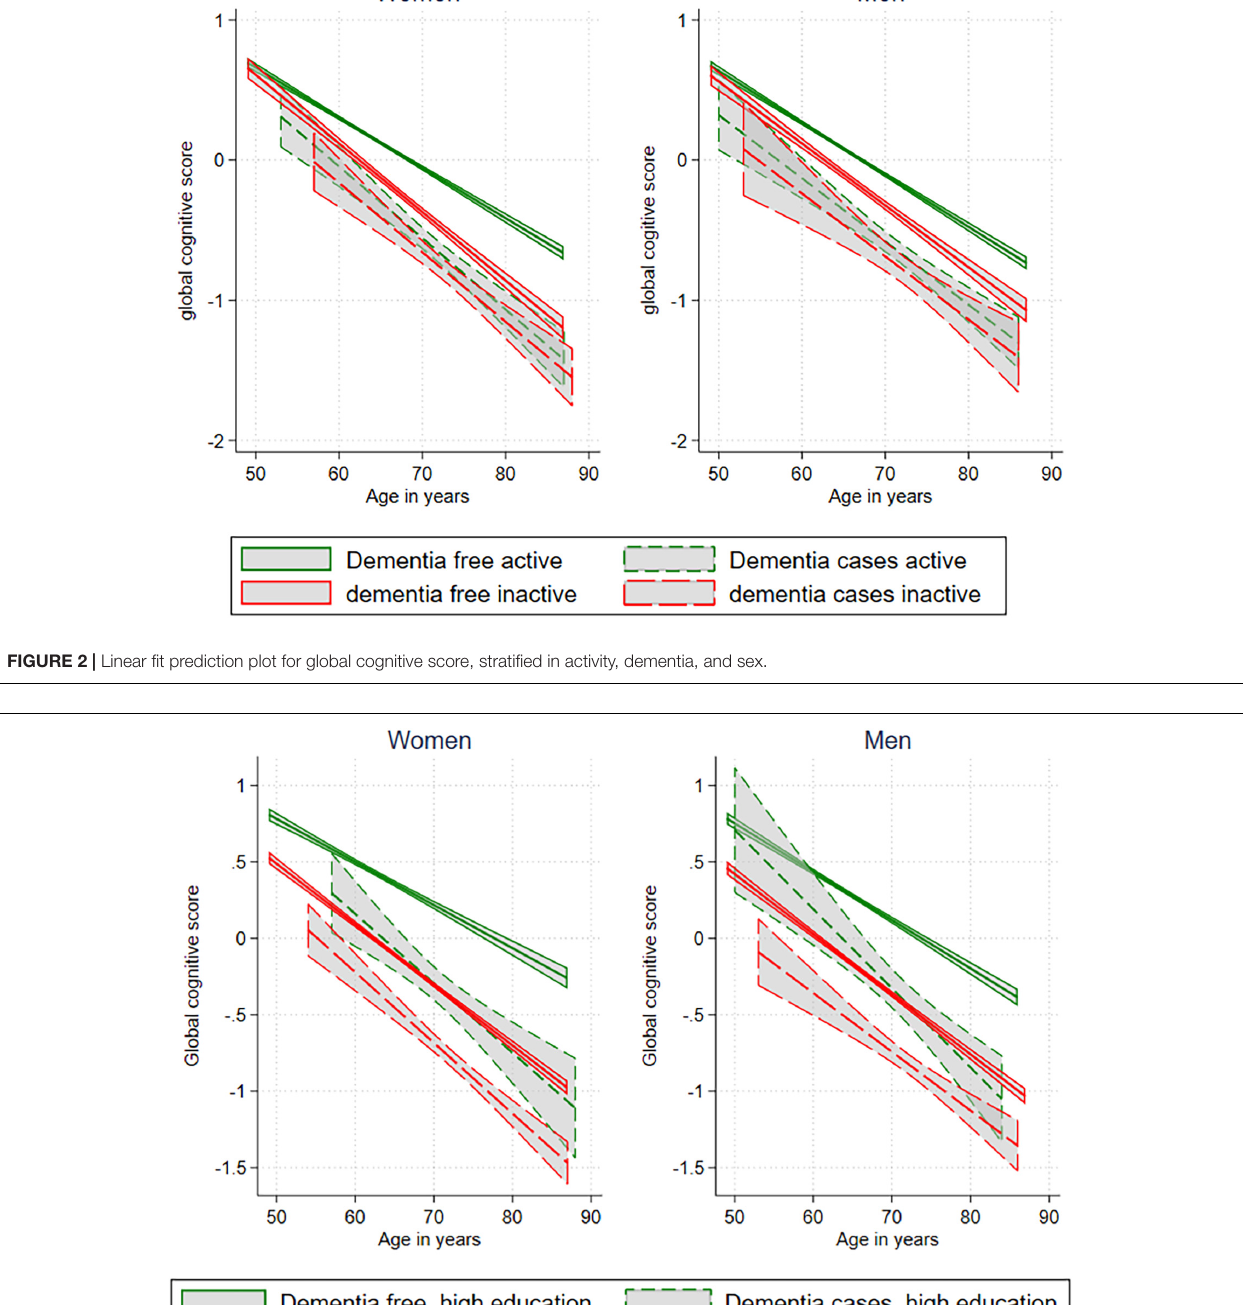
were non-significant after adjusting for this covariate. For the Digit Symbol Coding Test, the association remained statistically significant after adjusting for education for both groups, even